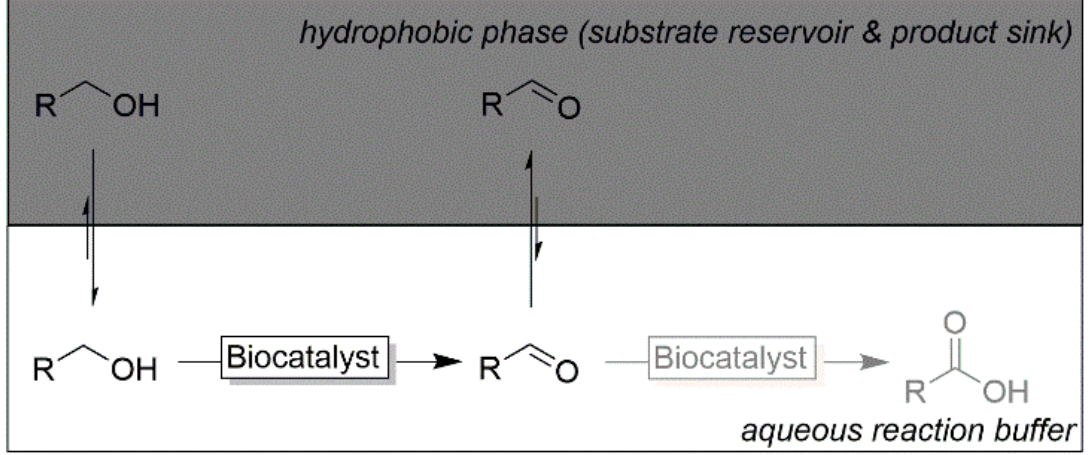
Table 2. Controlling the selectivity of the whole-cell catalyzed oxidation of primary alcohols.